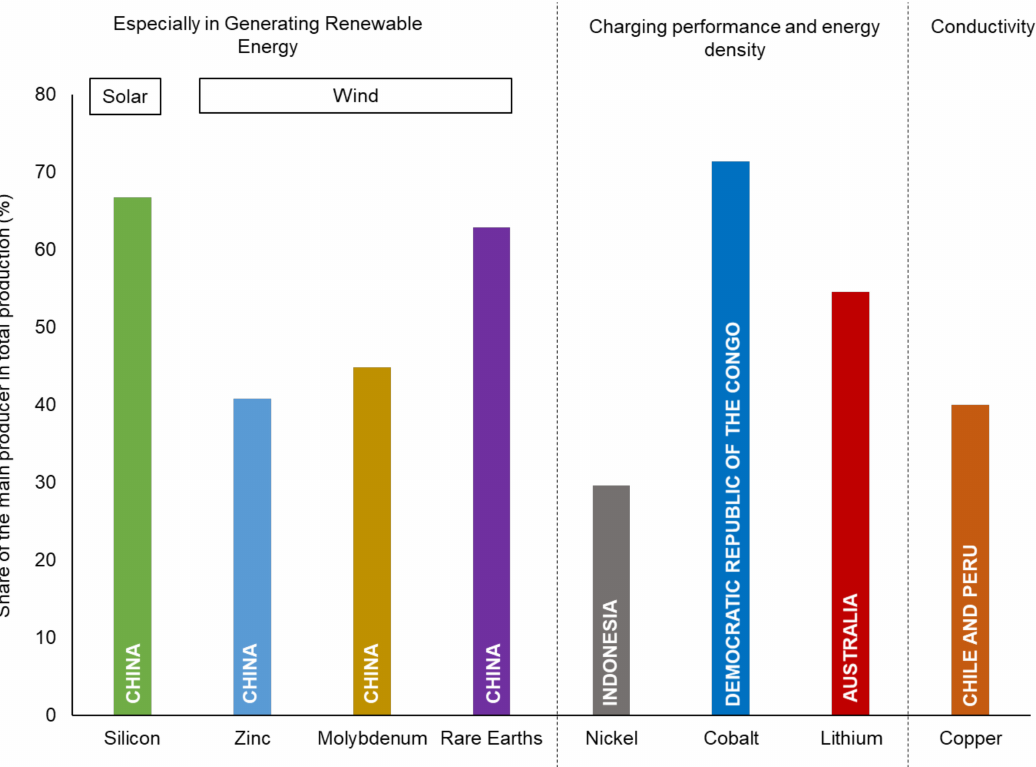
Figure 2. Supplies of minerals that support energy production. Information collected from [25], except for zinc [26] and silicon